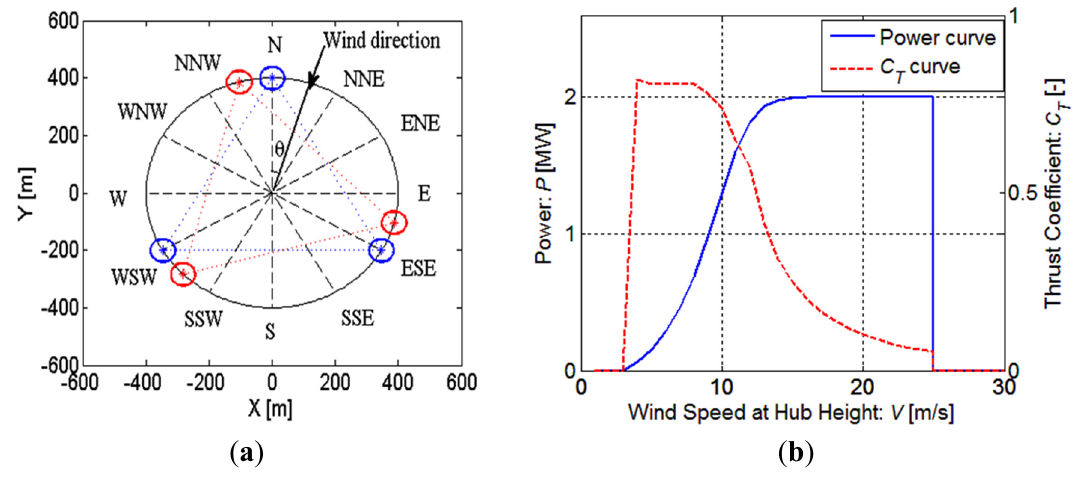
Figure 1. Constructed ideal WF composed of three WTs: ( a ) two possible layouts: Layout 1 (in blue), Layout 2 (in red); ( b ) characteristic curves of a Vestas V80